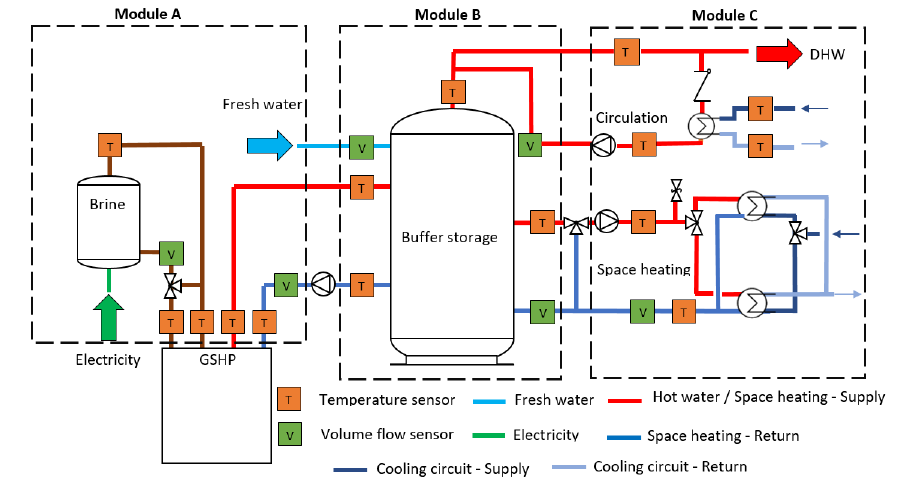
Figure 3. Hydraulic schematic of the heat pump testbed